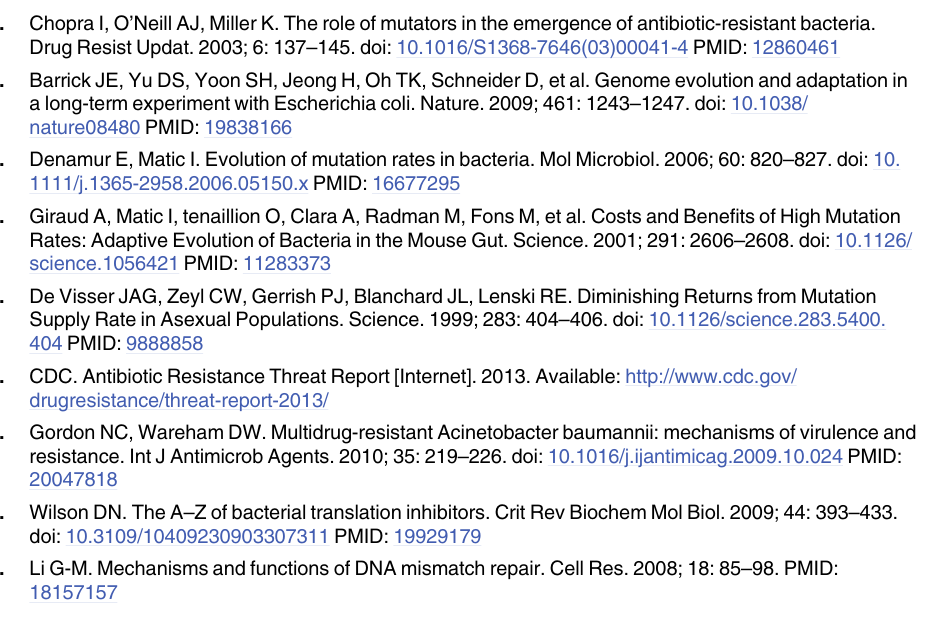
S5 Table. Genomic Differences between AB210 and AB210M. AB210M contains 50 muta- tions not present in AB210. The mutations are listed along with the genome positions and gene number (locus ID from patricbrc.org). S6 Table. Mutations in ade family genes. Here, we list the ade family genes that contained at least one mutation in a sample.